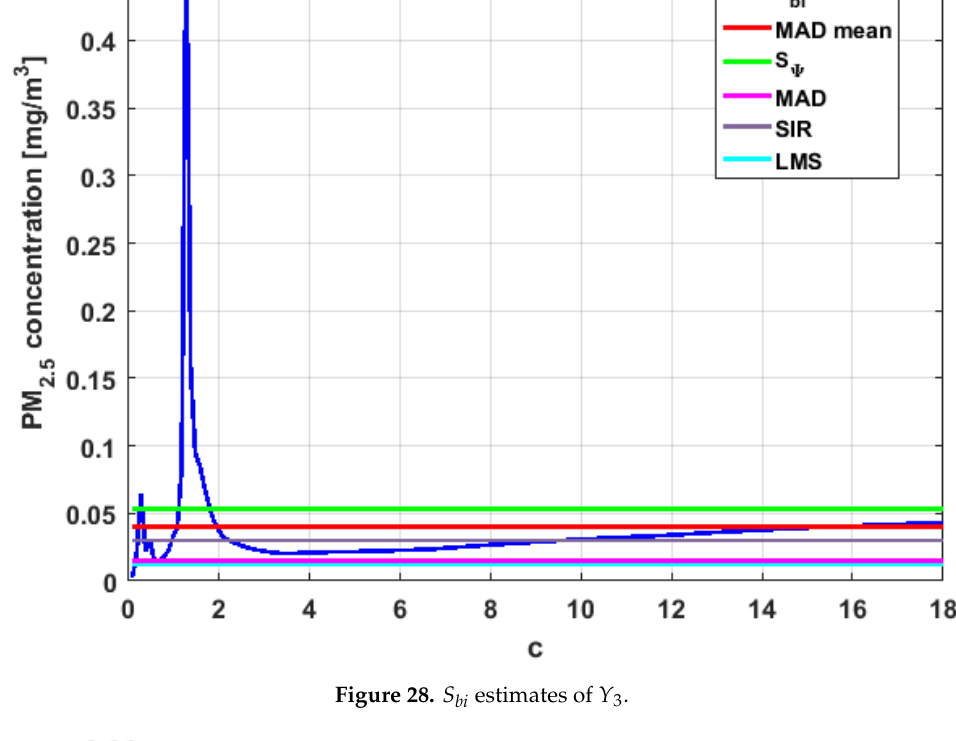
Figure 28. 𝑆 𝑏𝑖 estimates of 𝑌 3 . Figure 28. S bi estimates of Y 3 .